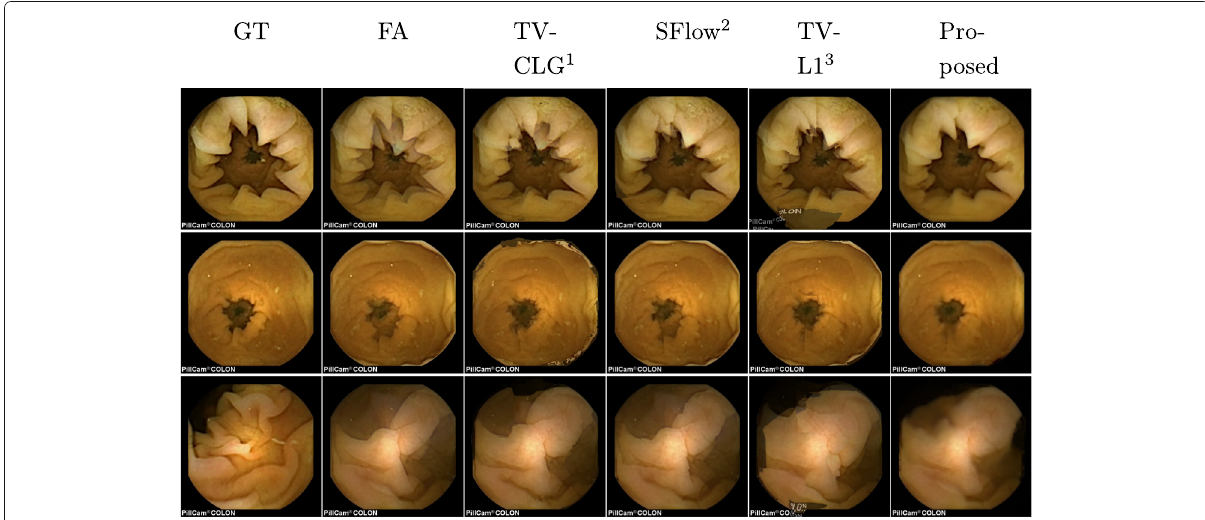
Fig. 3 Visual comparison of interpolated images. The first and second rows show the performance of different methods. On the last row, we can observe that the interpolated frame is significantly different from the ground truth. This is due to large displacement between the neighboring frame, with correlation value between them being 0.691. In our approach, interpolation is done when we are confident on the interpolated frame. More details are given under Section 5.4